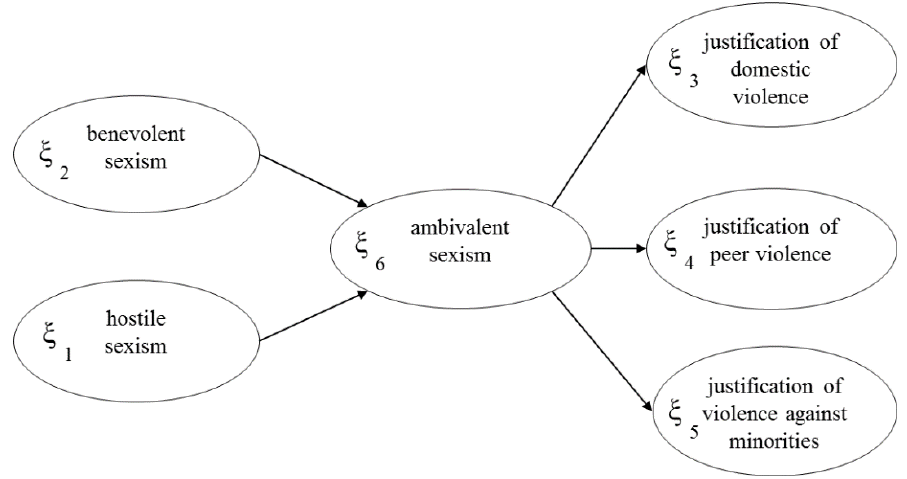
Figure 1. The structural model of ambivalent sexism: relationships between latent variables. The MVs of hostile and benevolent sexism were the items on the Ambivalent Sexism Inventory for adolescents [4], while the MVs of the justification of peer violence, the justification of domestic